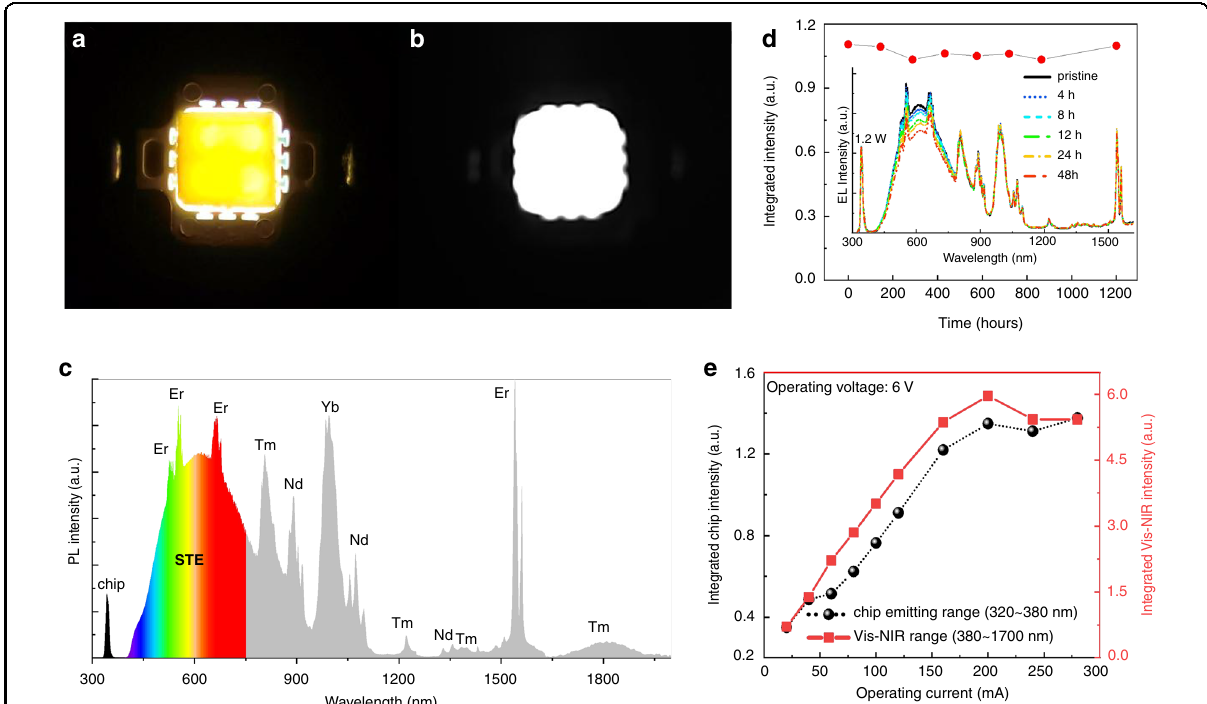
Fig. 4 Construction of ultrabroadband LED based on Bi/Ln:DP@glass composite. Photographs of the constructed Bi/Ln:DP@glass-based LED device with an operating current of 200 mA taken by ( a ) a visible-light camera and ( b ) NIR camera. c PL spectrum of the LED device. d Dependence of the PL intensity of the LED on the exposure time in air. The inset shows the PL spectra of LEDs continuously operating for 48 h. e Dependence of the UV-emitting intensity of the chip and Vis – NIR-emitting intensity of DiP on the operating current from 20 to 350